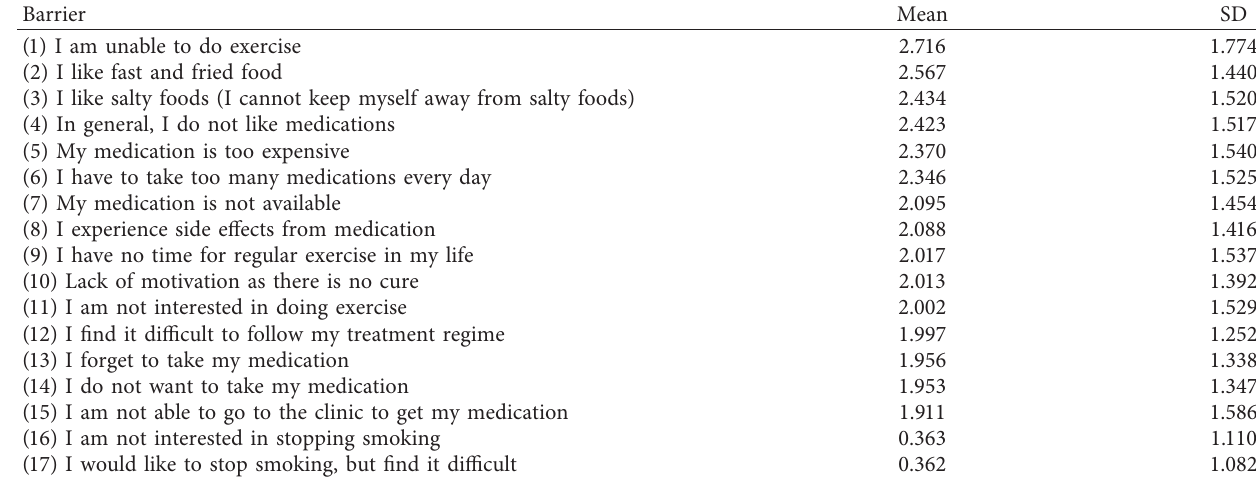
Table 9: Reported barriers to adherence to hypertension therapy.